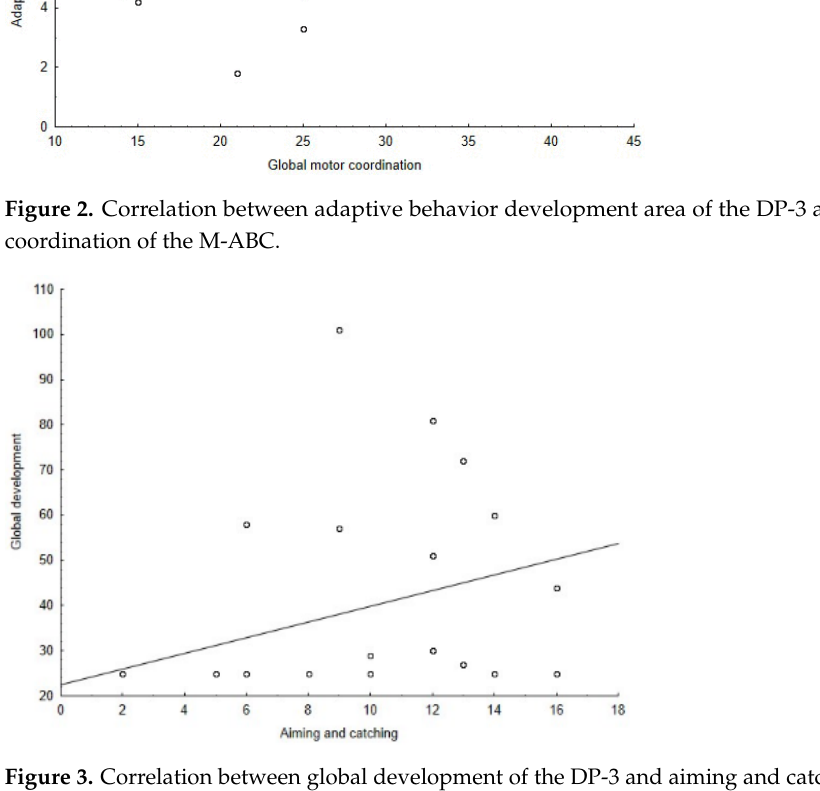
Figure 3. Correlation between global development of the DP-3 and aiming and catching skills of the M-ABC.